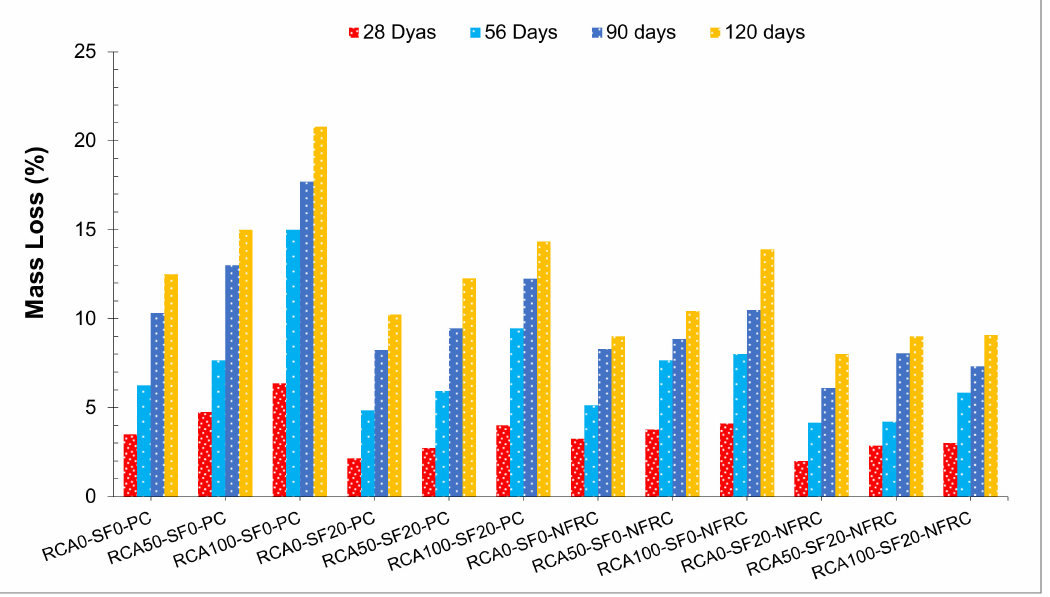
Figure 7. Concrete Mass Loss Due to Sulfuric Acid